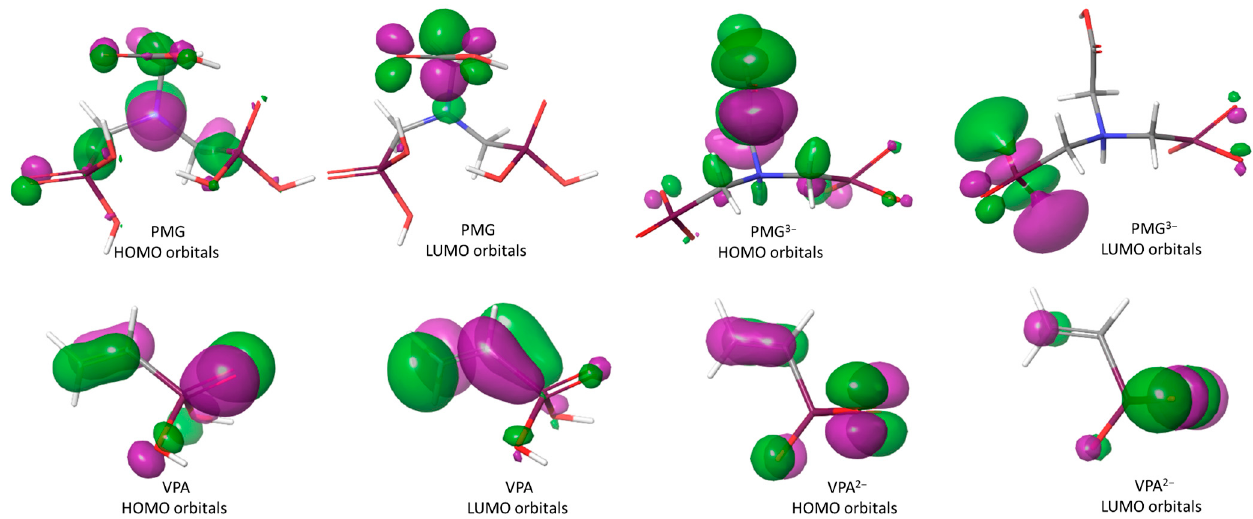
Figure 4. Highest occupied molecular orbital (HOMO) and the lowest unoccupied molecular orbital (LUMO) of PMG, PMG 3 − , VPA, and VPA 2 − compounds.